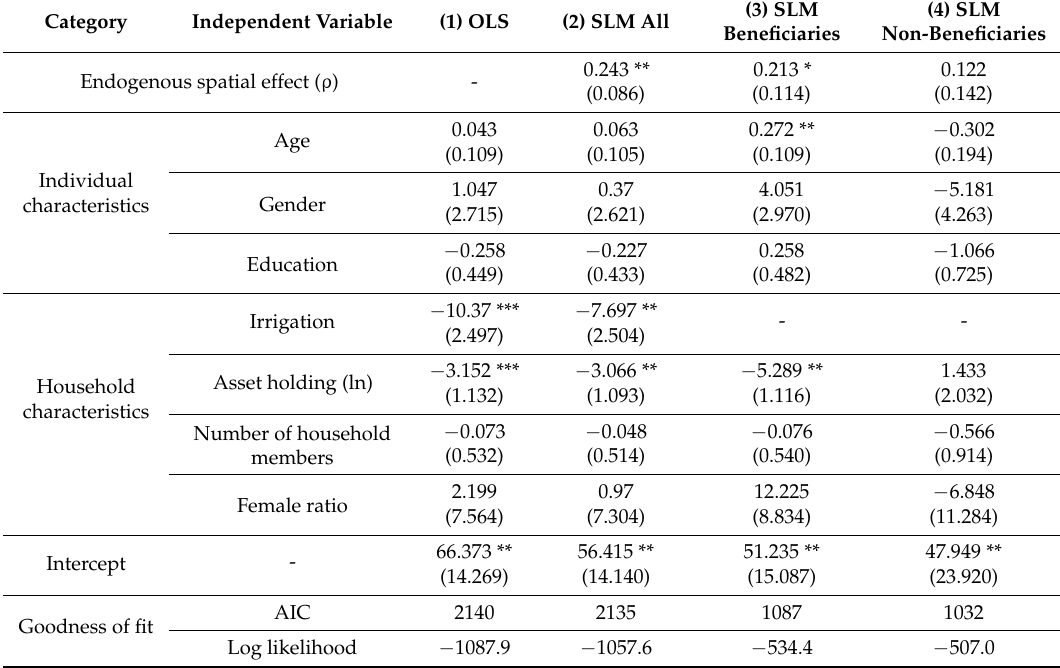
Table 4. Results of the Spatial Lag Model (SLM) regressions of the Ultimatum Game (UG) results on the spatial spillover effect and individual/household characteristics. Dependent variable: UG results (receiver’s